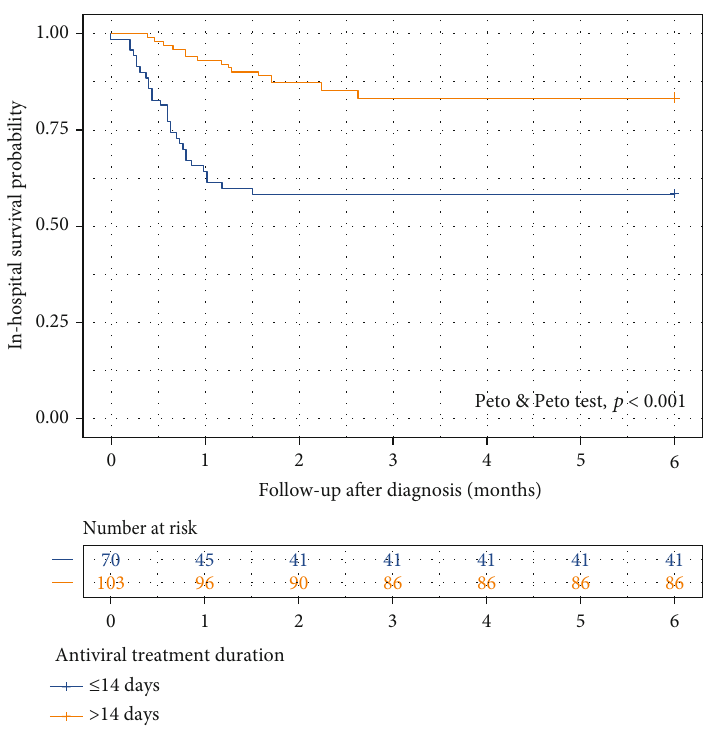
Figure 3: Survival probability of patients receiving antiviral treatment at di ff erent duration.